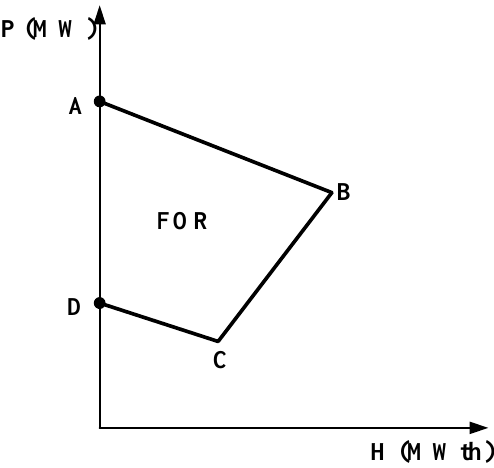
Figure 1. Possible operating area of CHP unit